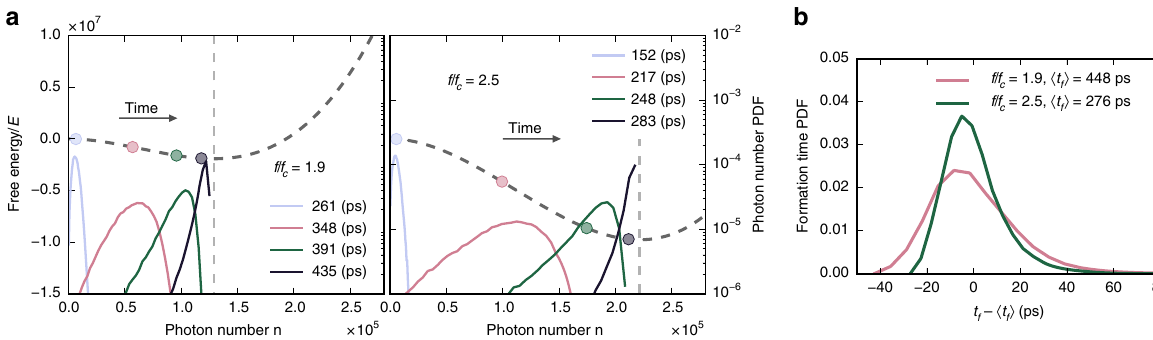
Fig. 9 Free-energy description of non-equilibrium photon condensation. a The photon number probability distribution function (PDF) (coloured lines), describing fl uctuations of the order parameter for two different initial excitation fractions. The circles indicate the expected value of n at a given time instant. While the latter is essentially Gaussian noise, the free-energy convexity far from the equilibrium point induces non-Gaussian, heavy-tailed statistics in photon number. This skewed statistics partially explains the limitations of the quantum regression model described in “ Results ” section. b The PDF of the condensate formation time, taken as the instant at which the photon number of each realization grows beyond 80% of that which minimizes the free energy (equilibrium point). We observe both the slowing down of the condensate formation, as well as the increasing jitter closer